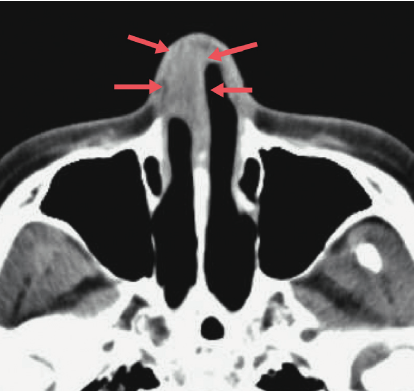
Figure 2: Computed tomography scan revealed a mass lesion localized in the anterior part of the right nasal cavity